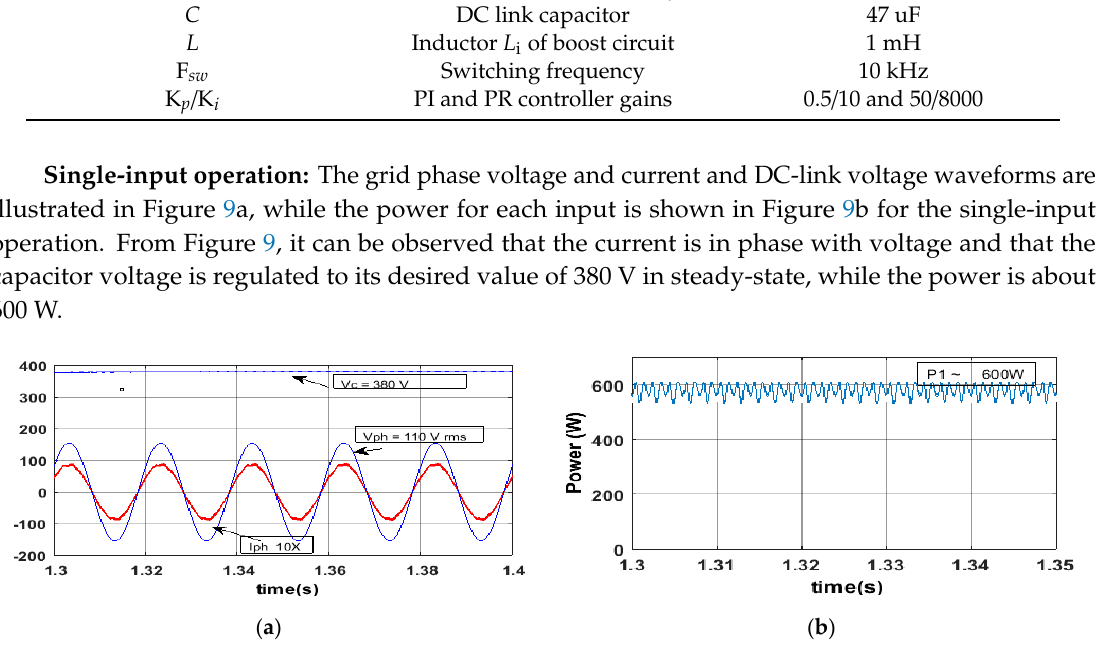
Figure 9. Steady-state response from numerical simulation of the single-input operation ( a ) the capacitor voltage V C , the grid phase voltage V ph , and current I ph , ( b ) the PV power for each input.